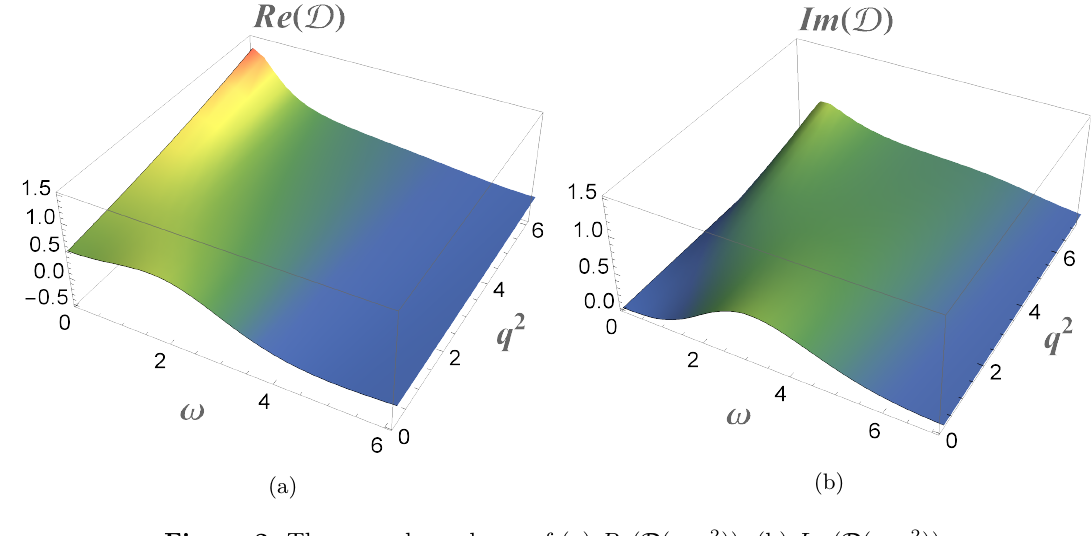
Figure 2 . The ω -, q -dependence of (a) Re ( D ( ω, q 2 )) , (b) Im ( D ( ω, q 2 )) .